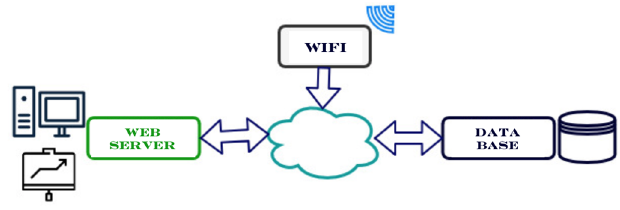
Figure 4. Nodo de Almacenamiento y Monitoreo (NAM) block diagram.